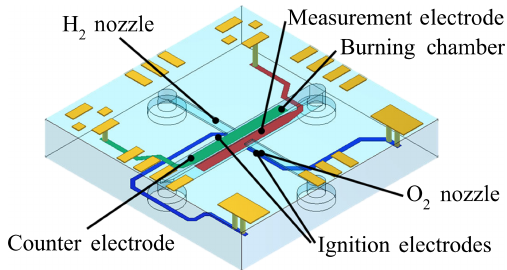
Figure 2. Schematic drawing of the ceramic µFID in planar counter-current design.